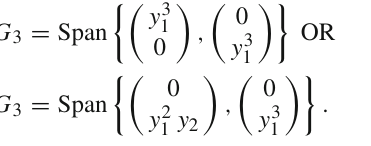
+ x 2 = a 2 on the ( x The circle x 2 1 2 to points on the circle X 2 + Y 2 = on S 2 ; The circle at infinity of ( x 1 , x 2 ) -plane corresponds to